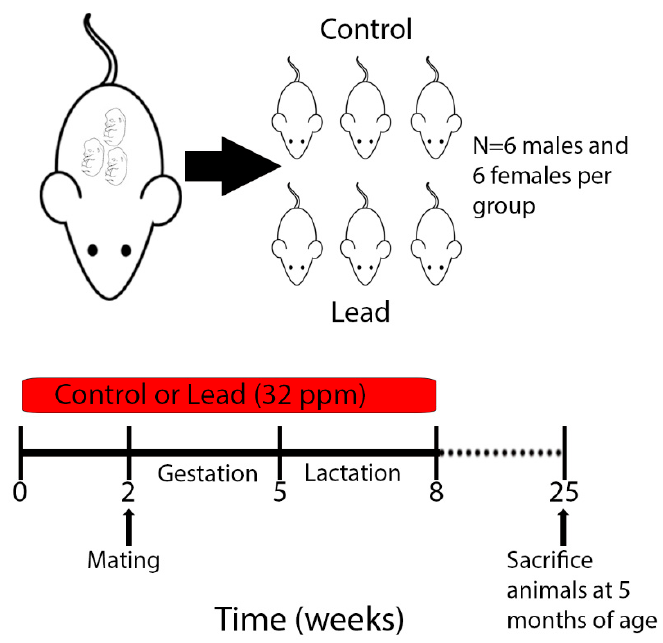
Figure 1. Schematic of experimental design and sample collection. Dams were exposed to Pb 2 weeks prior to mating via drinking water. Maternal (and, in turn, offspring) exposure continued until weaning, when offspring reached 3 weeks of age. 6 males and 6 females per exposure were sacrificed at 5 months of age for tissue collection and ERRBS analysis.